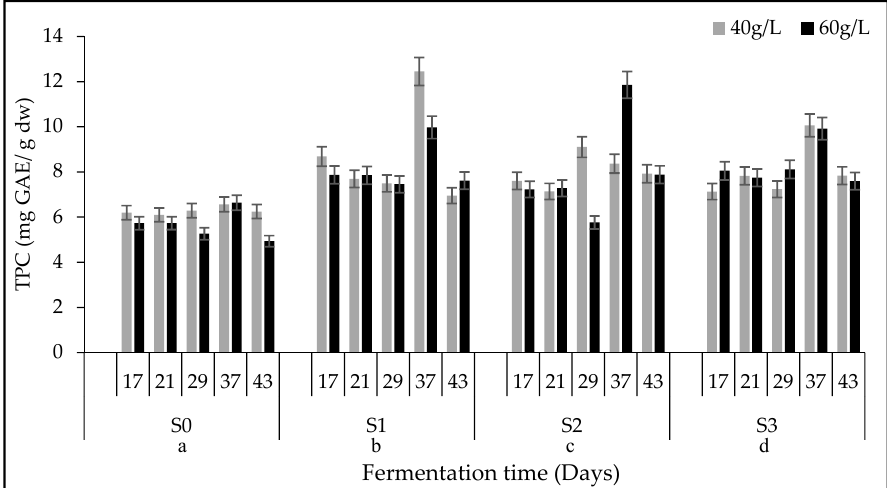
Figure 5. Phenolic compounds (TPC, mg GAE/g dw) produced during the cultivation of P. pulmonar- ius in liquid cultures with OMWs containing: (a) 0 g/L phenolic compounds and initial concertation glucose 40 and 60 g/L (S0-G40, S0-G60), (b) 1 g/L phenolic compounds and initial concertation glucose 40 and 60 g/L (S1-G40, S1-G60), (c) 2 g/L phenolic compounds and initial concertation glucose 40 and 60 g/L (S2-G40, S2-G60), (d) 3 g/L phenolic compounds and initial concertation glucose 40 and 60 g/L (S3-G40, S3-G60). Each point is the mean value of at least three independent measurements, SD < 5%.